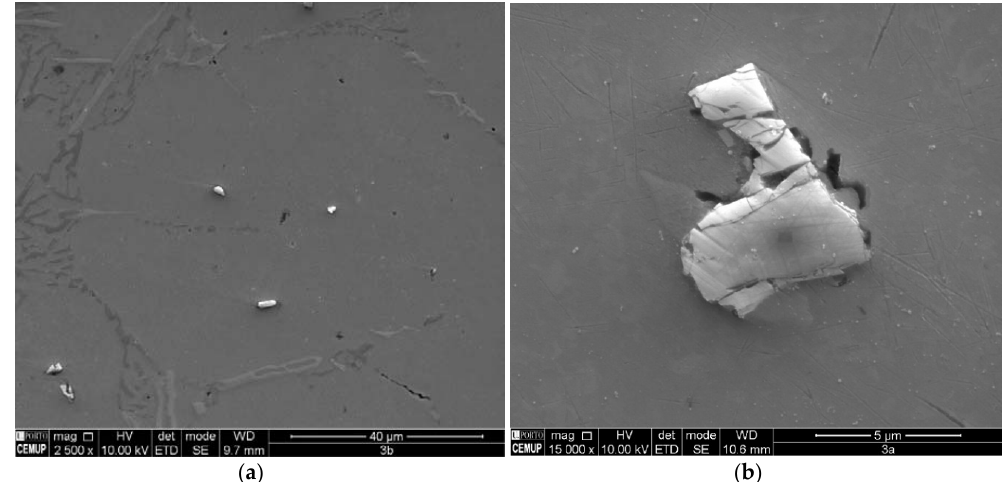
Figure 10. Detail of particle bonding in the α‐ Al matrix. ( a ) Condition 3 ‐ Position 3b; ( b ) Condition 3 ‐ Position 3a.